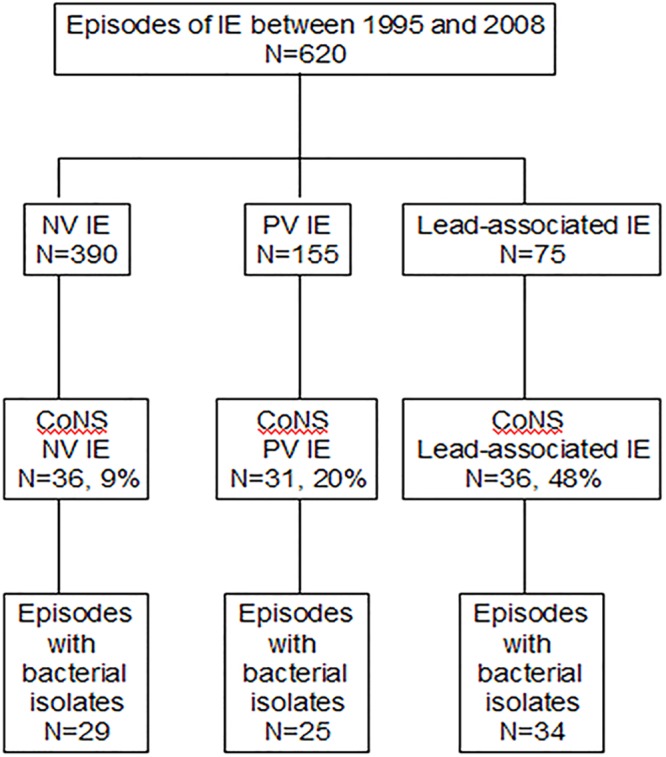
Patient disposition.Abbreviations: IE, infective endocarditis; NV, native valve; PV, prosthetic valve; CoNS, coagulase-negative staphylococci.